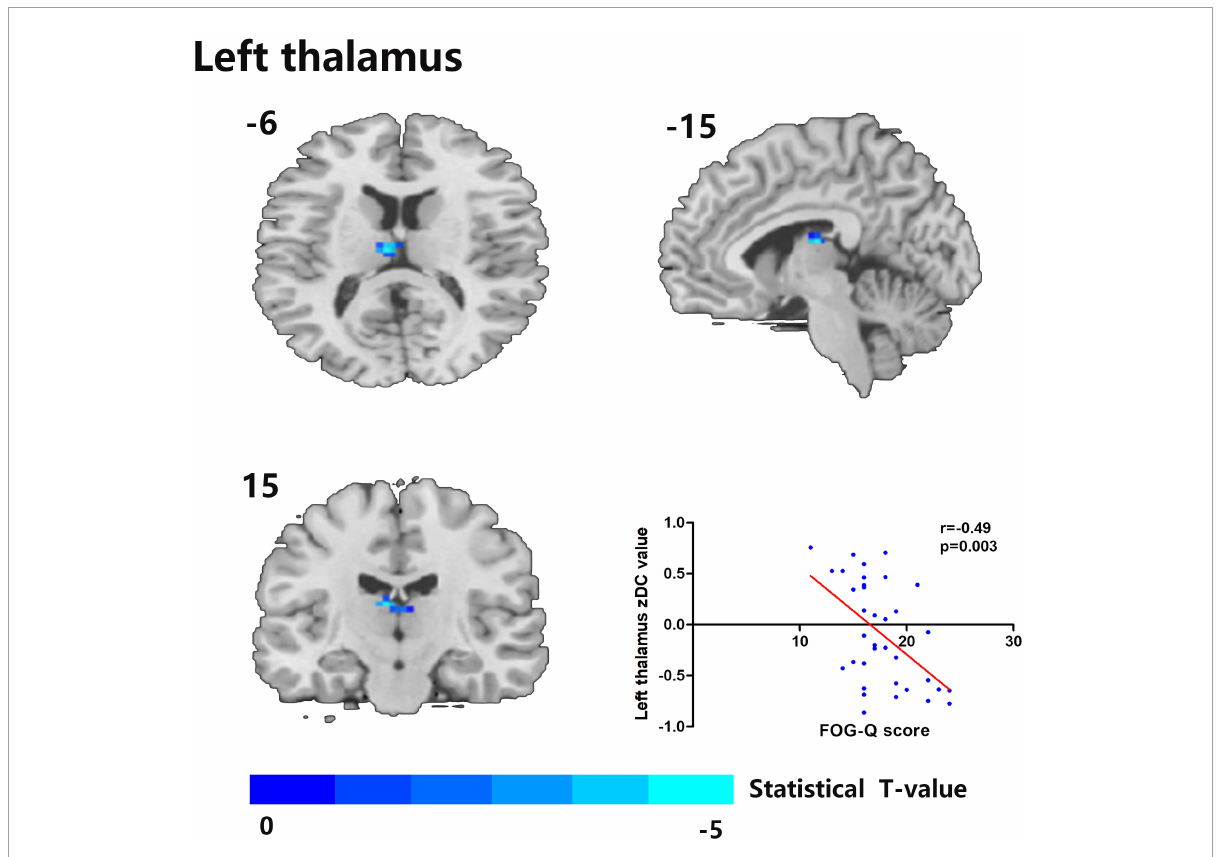
FIGURE2 The left thalamus was the only degree centrality (DC)-altered brain area in correlation with FOG-Q scores between MSA-FOG and MSA-nFOG groups. Scatter plot showed a negative correlation between FOG-Q scores and the left thalamus zDC values in patients with